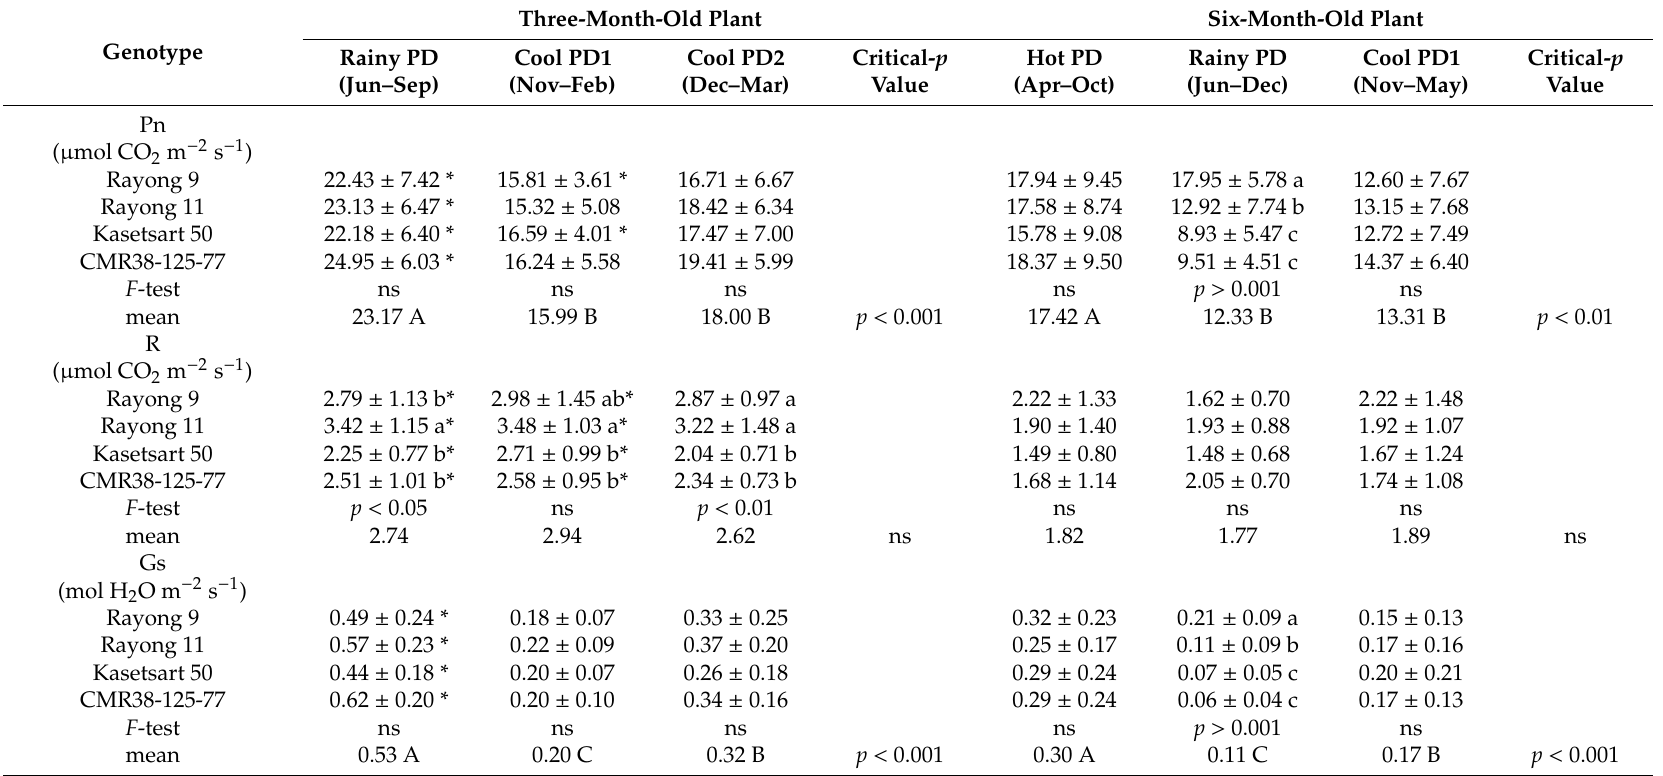
Table 2. Leaf gas exchange parameters including net photosynthesis rate (Pn), respiration rate (R), stomatal conductance (Gs), transpiration rate (Tr), ratio between intercellular and ambient CO 2 concentration (Ci / Ca), and water use e ffi ciency (WUE) of cassava Rayong 9, Rayong 11, Kasetsart 50, and CMR38-125-77 planted in April (Hot PD), June (Rainy PD), November (Cool PD1), and December (Cool PD2) in 2015. Mean values were from six canopy levels of six plants of each genotype. Significantly di ff erent means among genotypes were denoted with di ff erent lower case letters, whereas those among PDs were represented by di ff erent capital letters. Means that were significantly di ff erent ( p < 0.05) between 3- and 6-month-old plants of the same PDs are denoted with